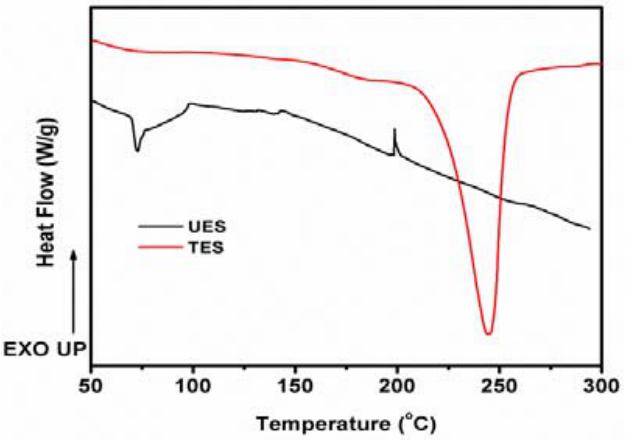
Figure 3. DSC curves of UES and TES particles .